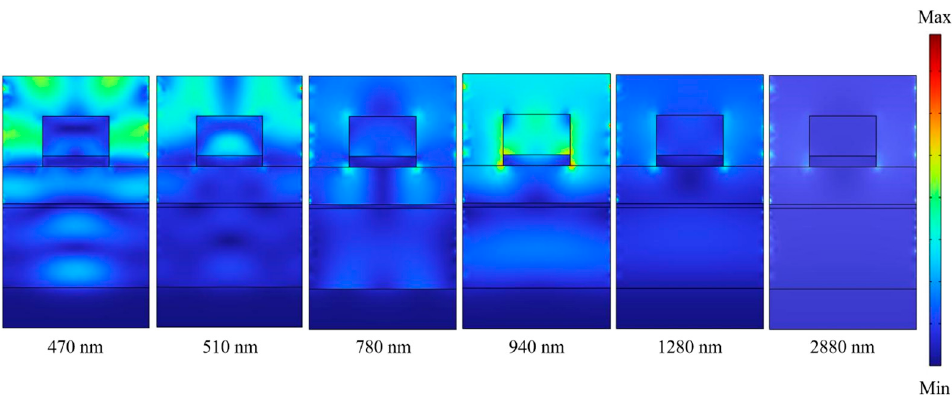
Figure 6. Distributions of electric field intensities under normal incident TE polarized light with different exciting wavelengths.